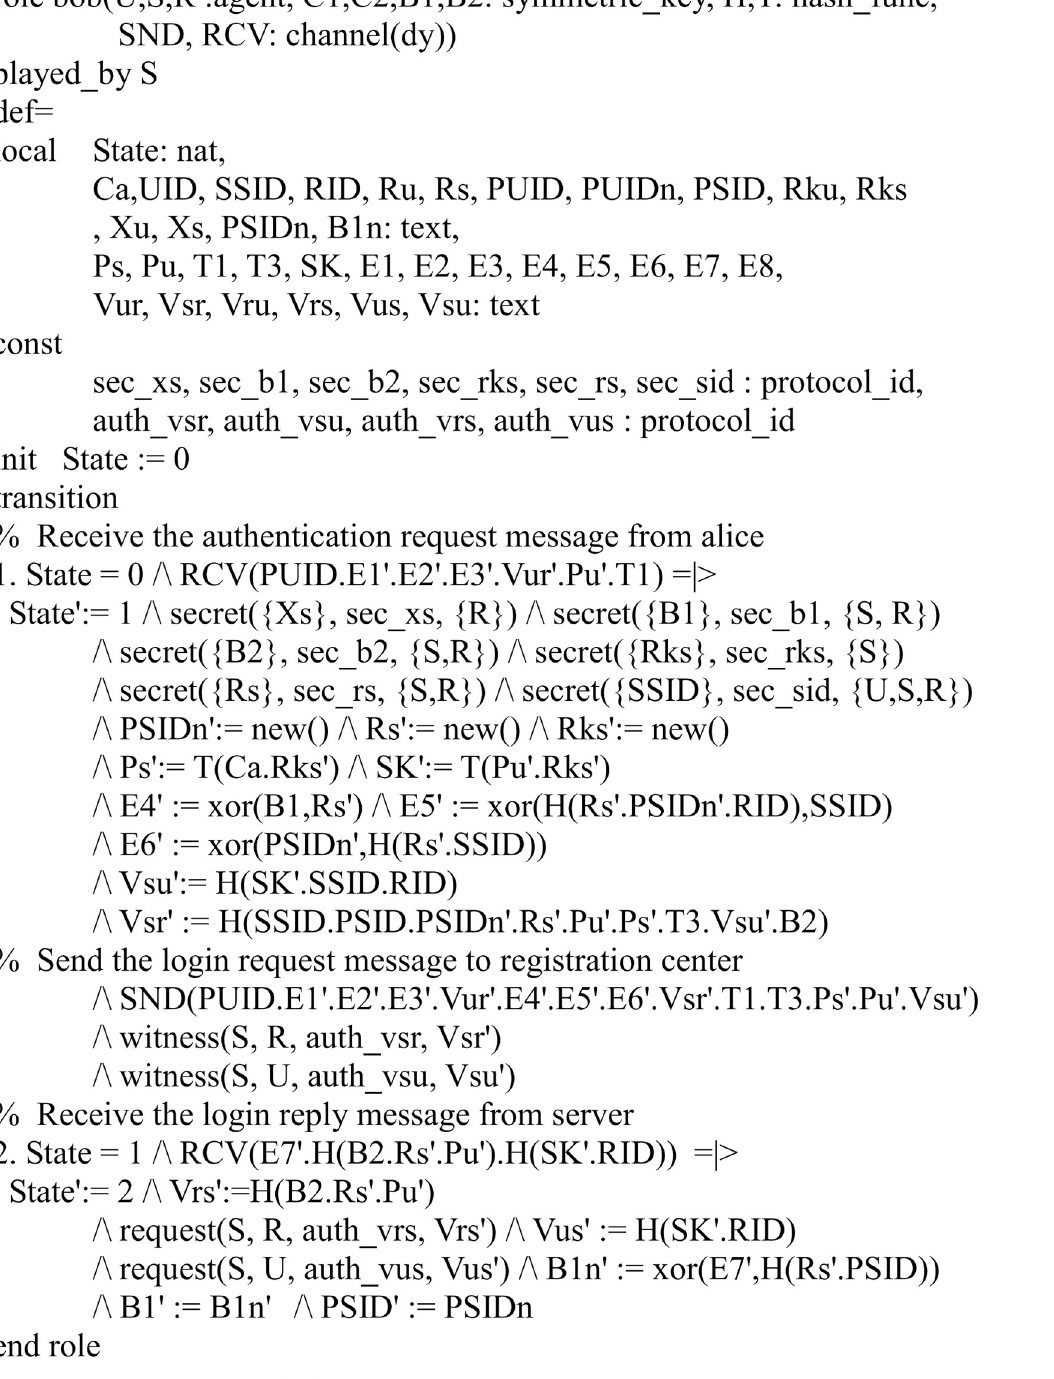
Fig 5. Role specification in HLPSL for the server S